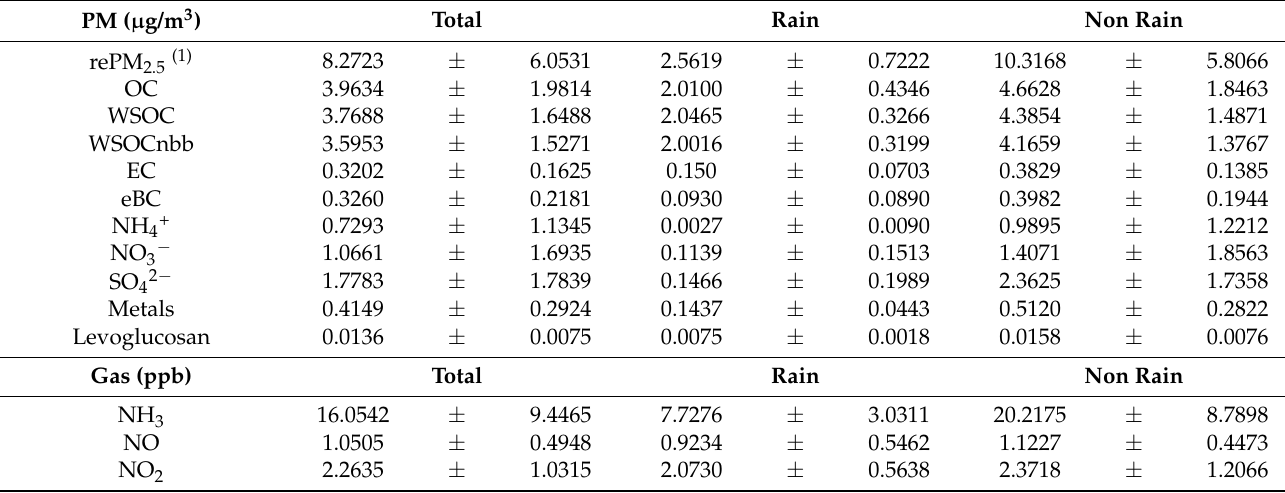
Table 2. Analysis result of PM 2.5 chemical concentration in orchard